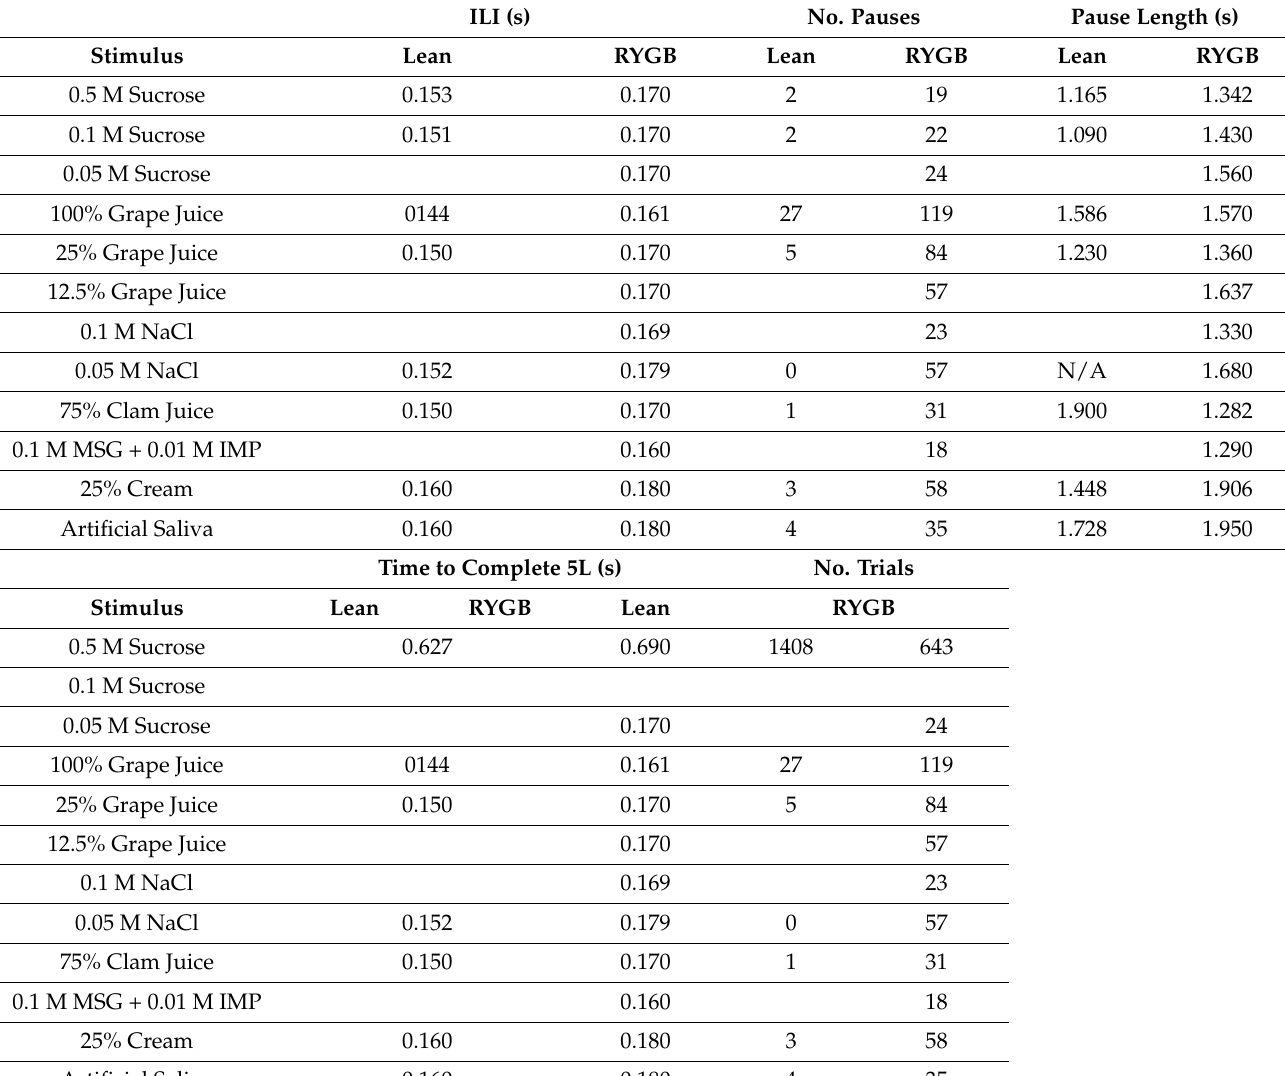
Table 3. Lick behavior in Lean and RYGB